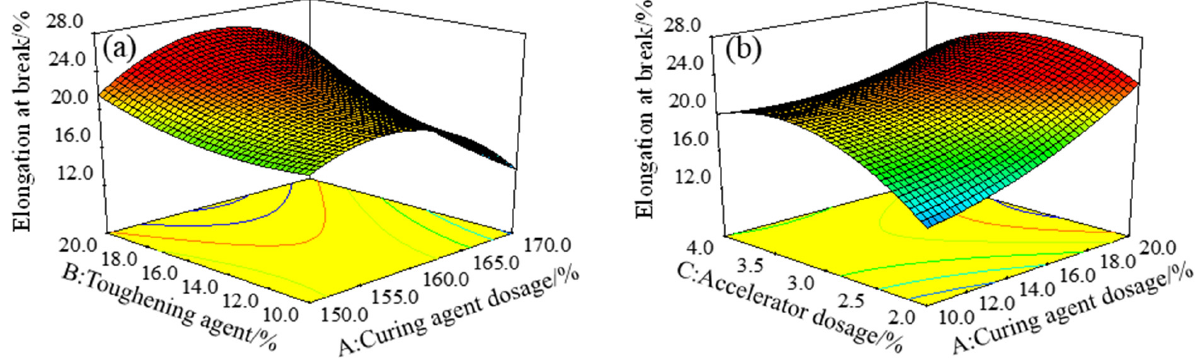
ε ) under the ( a ) interaction of factors A and B ,